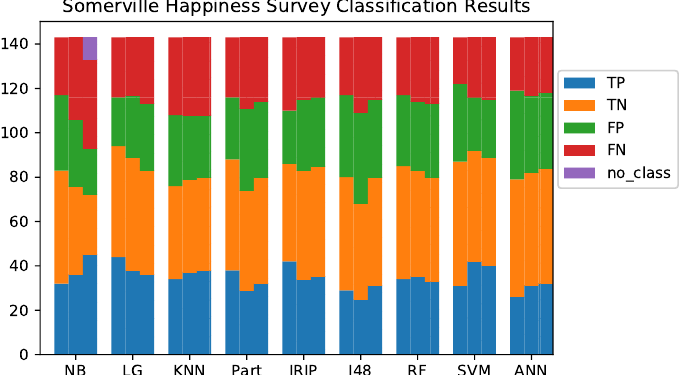
Figure A5. Graph corresponding to the Somerville Happiness Survey dataset. In blue are true positives, in orange are true negatives, in green are false positives, in red are false negatives, and in purple are unclassified